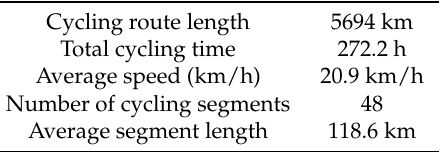
Figure 3. Multimodal data recorded during the whole cycling route (5694-km long) across the Andes mountains, presenting ( a ) GPS global and detailed altitude data; and ( b ) heart rate data with cycling segment specifications. Table 1. Specification of the cycling expedition across the Andes